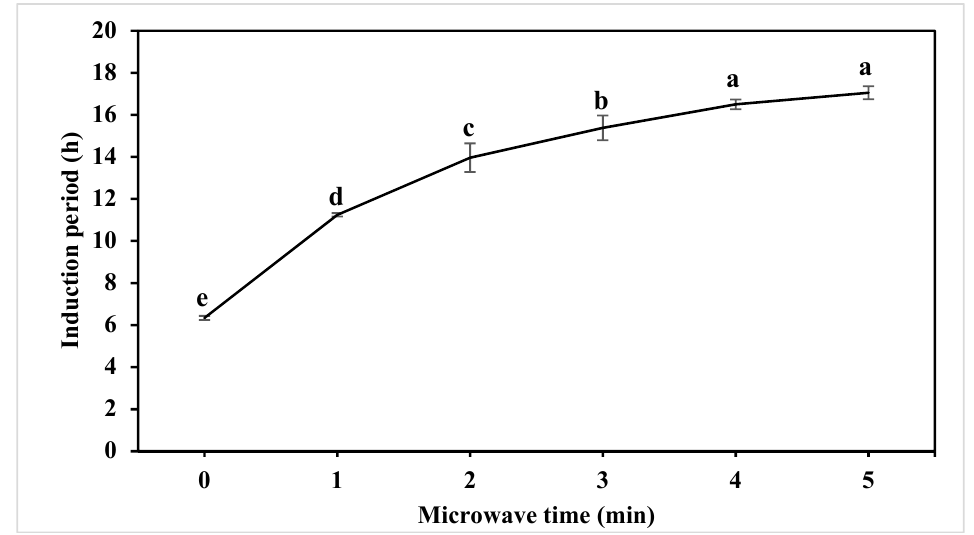
Figure 2. Effect of microwave pretreatment on the oxidative stability of oil. Different characters (a–e) on top of the line indicate significant ( p < 0.05) differences among samples with different treatment times.